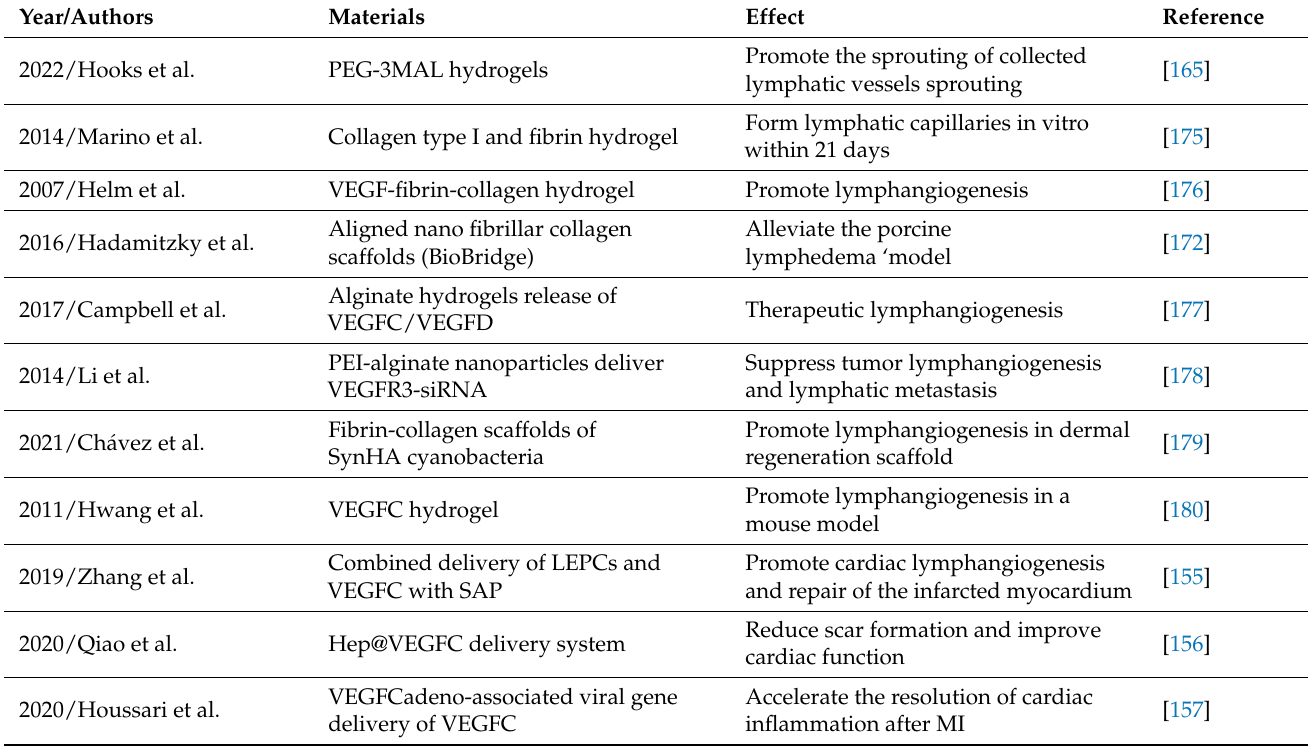
Table 3. Examples of tissue-engineered materials used to promote